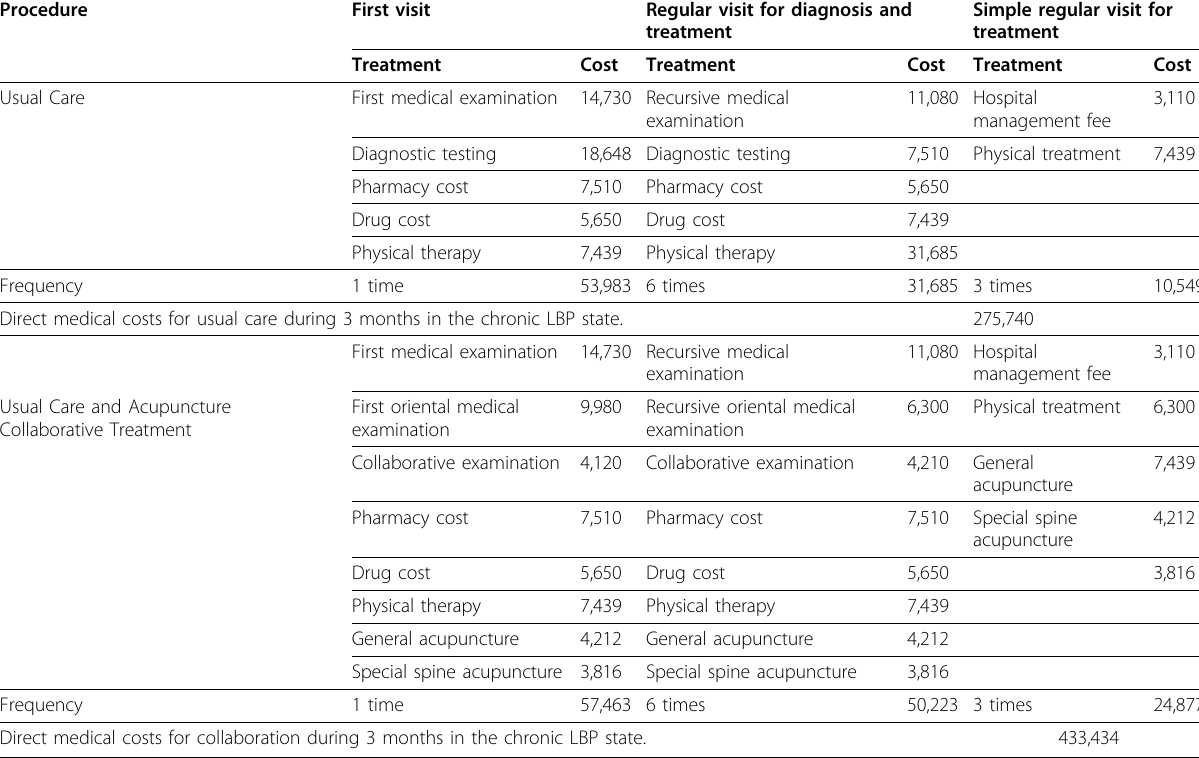
Table 1 Definitions of procedures and medical costs (KRW in 2009) 24